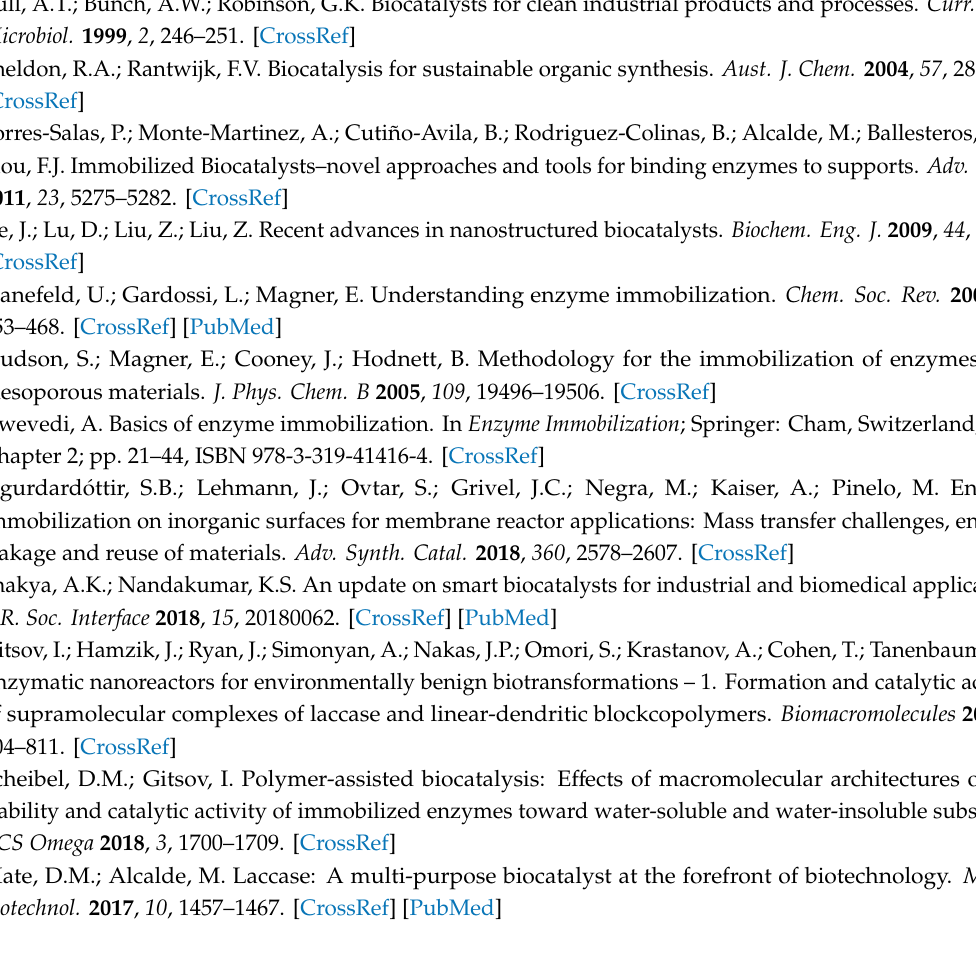
Figure S1: Chemical reactions occurring during AAROP of 2PD to PA4 microparticles; Figure S2: Histograms of the average size ( d max ) and roundness ( d max / d min ) distributions for PA4 MP supports based on optical microscopy; Figure S3: Disappearance of the scattering peak at q = 3.73 nm − 1 in the SAXS patterns after melting and recrystallization of PA4 MP support; Figure S4. Structures of the dyes used in the discoloration studies with PA4@iL and PA4@eL laccase conjugates; Figure S5. PA4-Fe-eL sample fast removal from DDW suspension by means of a constant magnet; Table S1: Data from BET for the empty PA4 supports; Table S2: Z-potential values of empty particulate PA4-based supports; Table S3: Consolidated DSC data from an initial heating scan, subsequent cooling scan, and a second heating scan at 10 deg /